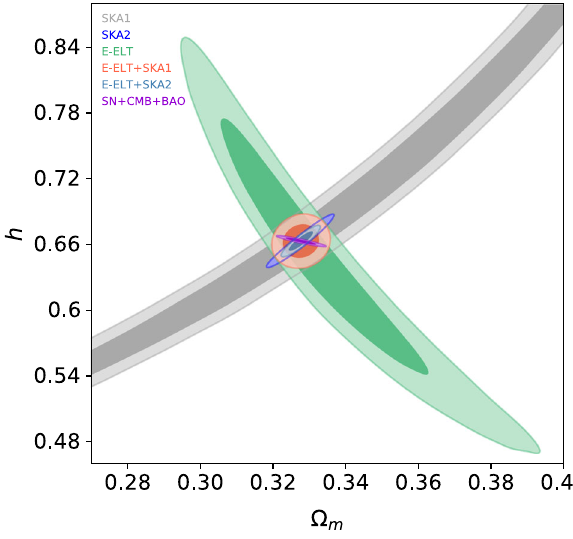
Fig. 2 Constraints (1 σ and 2 σ CL) on the (cid:2) CDM model in (cid:4) m – h planebyusingtheSKA1,SKA2,E-ELT,E-ELT+SKA1,E-ELT+SKA2, and SN+CMB+BAO data